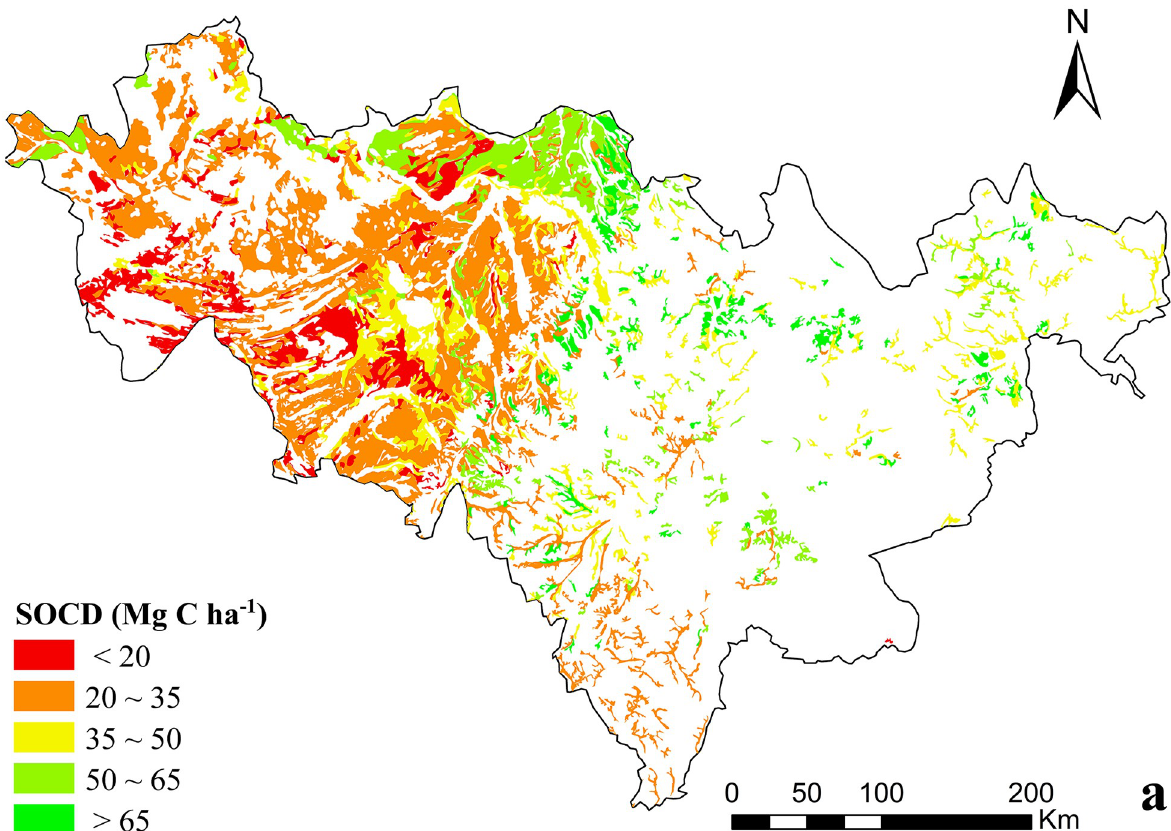
Fig 5. Spatial variability of SOCD of dry farmland in1985 of Jilin Province,